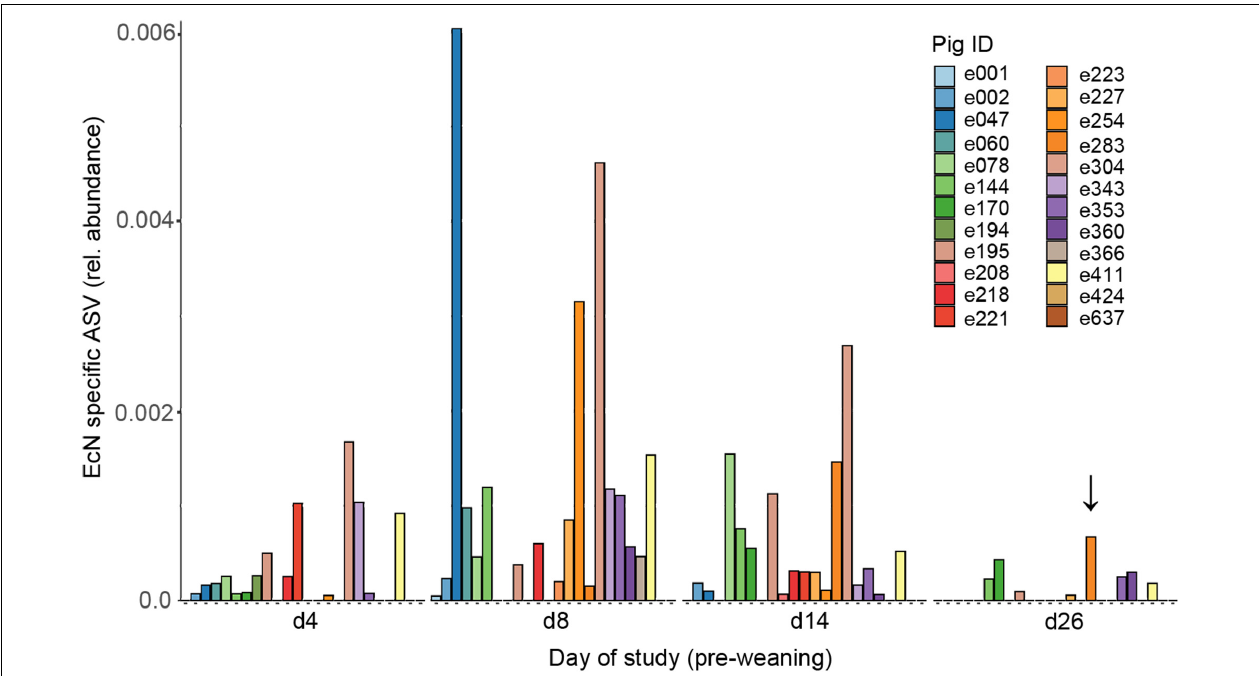
FIGURE 2 | Presence of EcN in feces from EcN-treated pigs during the pre-weaning period. Data are presented as the relative abundance of the EcN-specific ASV, as calculated from the NGS dataset. Colors correspond to an individual pig (Pig ID, n = 24). The arrow indicates the pig (e254) from which we also found EcN in the MLN by using colony PCR. EcN was not detected in the post-weaning period and therefore only the pre-weaning data is